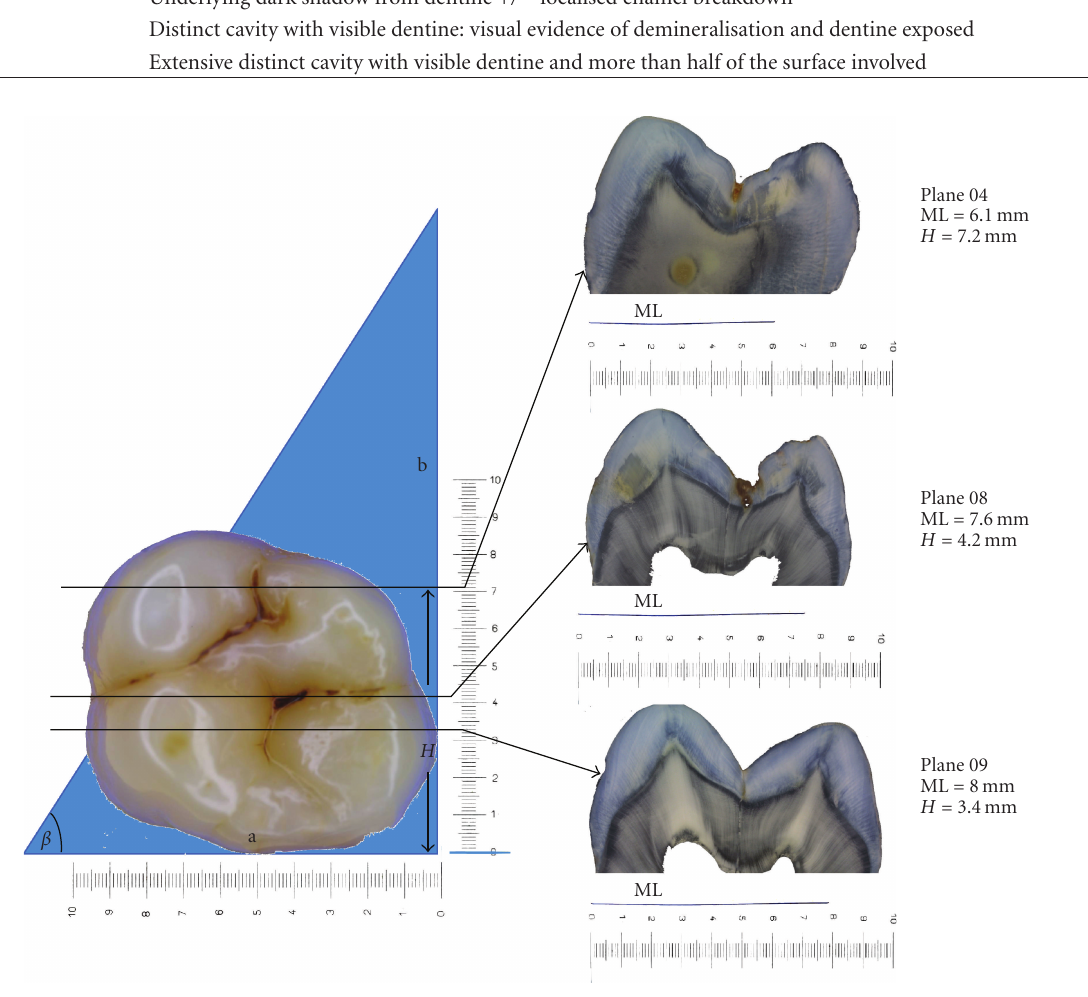
Figure 1: Occlusal view of a molar tooth with three investigation sites and the corresponding histological sections. The length of the embedded coloured foil allows accurate location of the section in the y -axis, using the formula H = 2 (a - ML). The position of the lesion along each section can be then determined by the x -axis